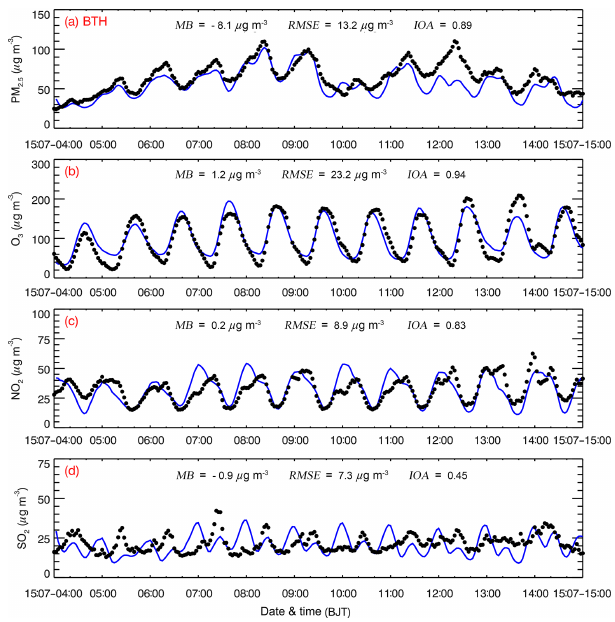
Figure 3. Comparison of observed (black dots) and simulated (blue line) diurnal profiles of near-surface hourly (a) PM 2 . 5 , (b) O 3 , (c) NO 2 , and (d) SO 2 averaged over all ambient monitoring stations in BTH from 4 to 15 July